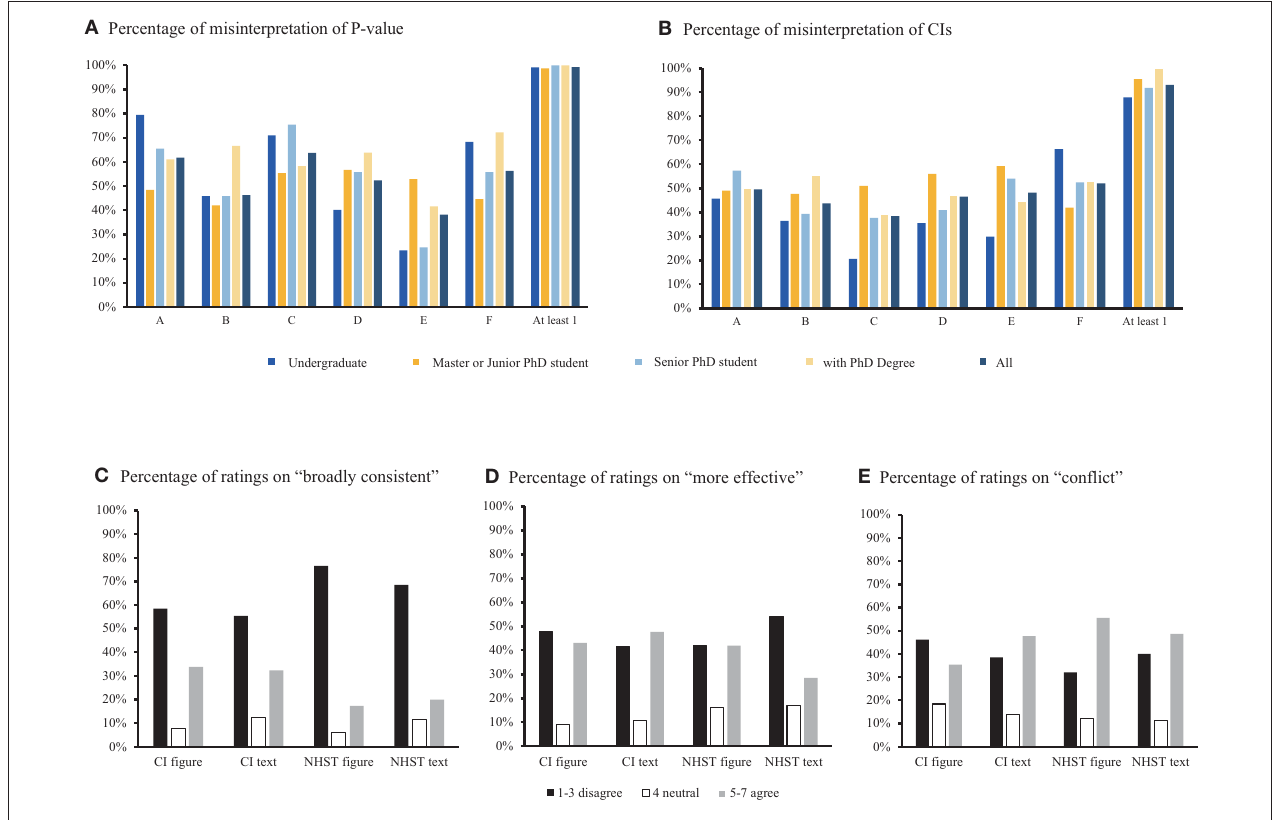
FIGURE 1 | Descriptive results from all valid data. (A) Percentage of respondents who misinterpreted the P -value, the “A” to “F” on X-axis represent six statements about P -value, “At least 1” means that respondents misinterpreted at least one statement; (B) Percentage of respondents who misinterpreted the CIs, the “A” to “F” on X-axis represent six statements about P -value, “At least 1” means that respondents misinterpreted at least one statement; (C) Response for the question on “broadly consistent” (in percentage); (D) Response for the question on “more effective”(in percentage); (E) Response for the question on “conflict” (in percentage). NHST text 20%; see Figure 1C ). For the statement that the new treatment is “more effective,” more respondents agreed when results presented in CI (CI figure, 43%, CI with text, 48%) than in NHST (NHST figure 42%, NHST text 29%; see Figure 1D ); For the statement that the two studies are “conflict,” there were more respondent agreed when results presented in NHST (NHST figure 56%, NHST text 49%) than in CI (CI figure, 35%, CI text, 48%; see Figure 1E